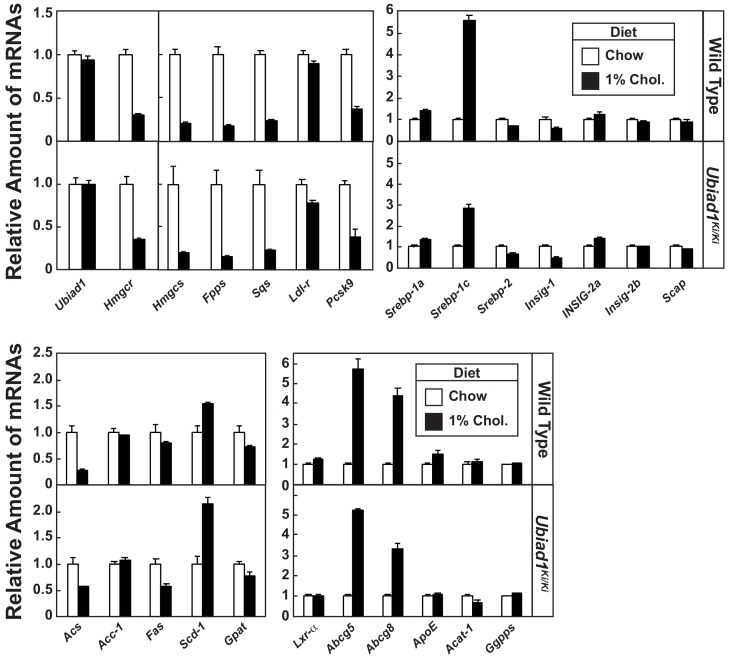
Effect of dietary cholesterol on expression of mRNAs encoding components of the Scap-SREBP pathway in livers of WT and Ubiad1 knock-in mice.Total RNA from livers of mice used in Figure 5A (5 mice/group) was separately isolated. Equal amounts of RNA from the individual mice were subjected to quantitative real-time RT-PCR using primers against the indicated gene; cyclophilin mRNA was used as an invariant control. Each value represents the amount of mRNA relative to that in WT mice fed a chow diet, which was arbitrarily defined as 1. Bars, mean ± S.E. (error bars) of data from five mice. ApoE, apolipoprotein E; Acat-1, acyl-coenyzme A:cholesterol acyltransferase-1.